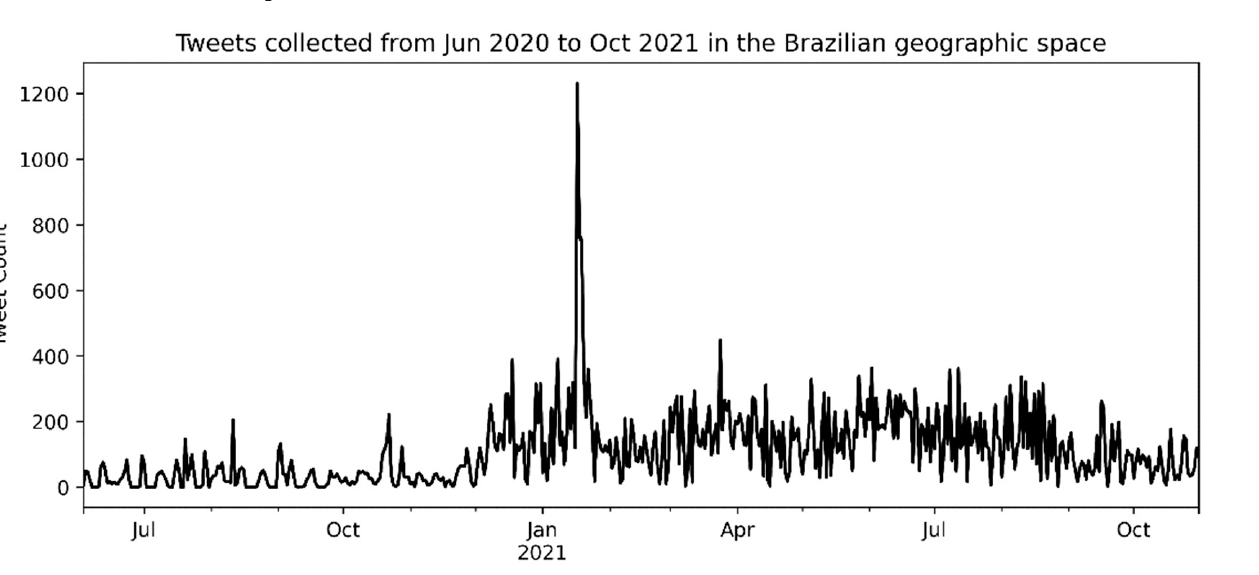
Figure 2. Overall tweets distribution over 17 months.